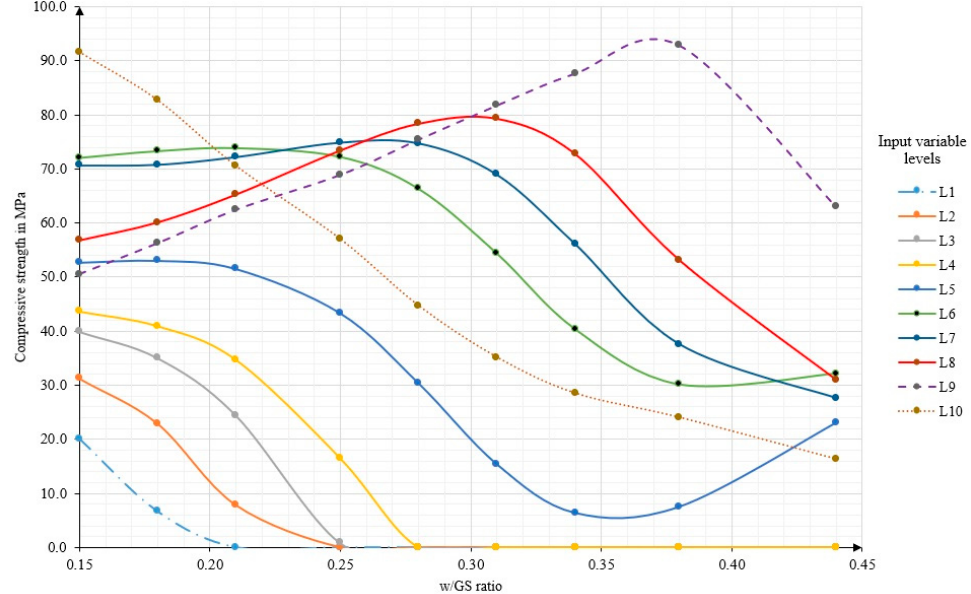
Figure 8. Compressive strength (f’c) vs. the water–geopolymer solid (w/GS) ratio for the ten levels of the input variables (L1–L10).